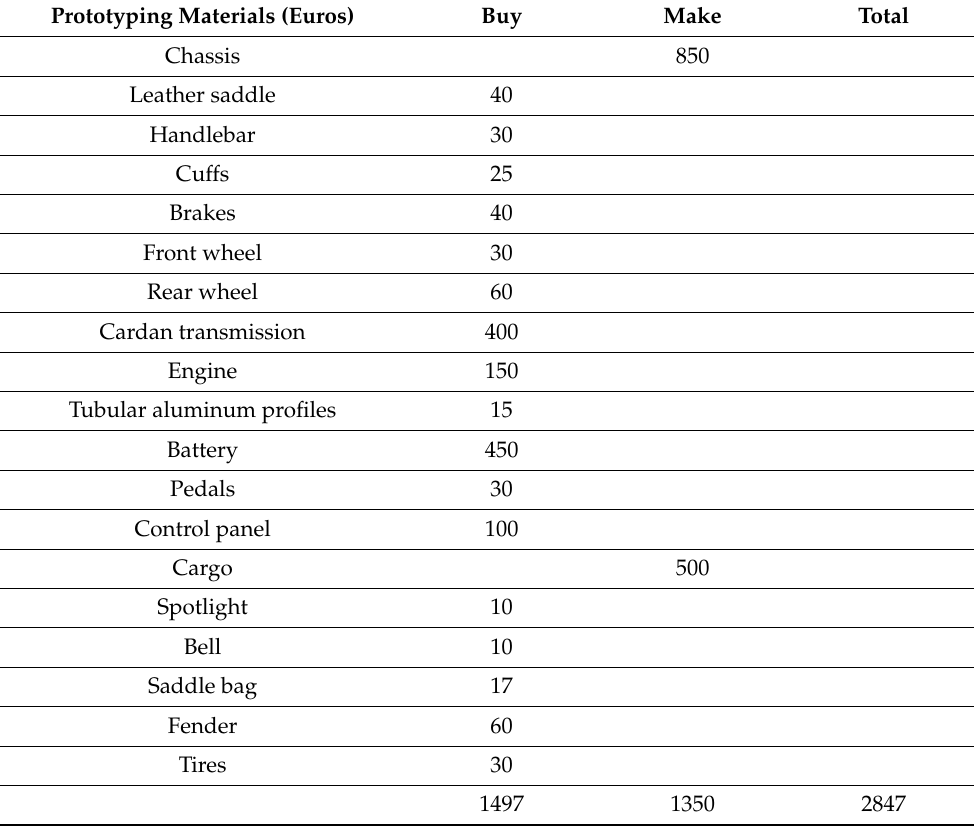
Table 6. Prototype costs.